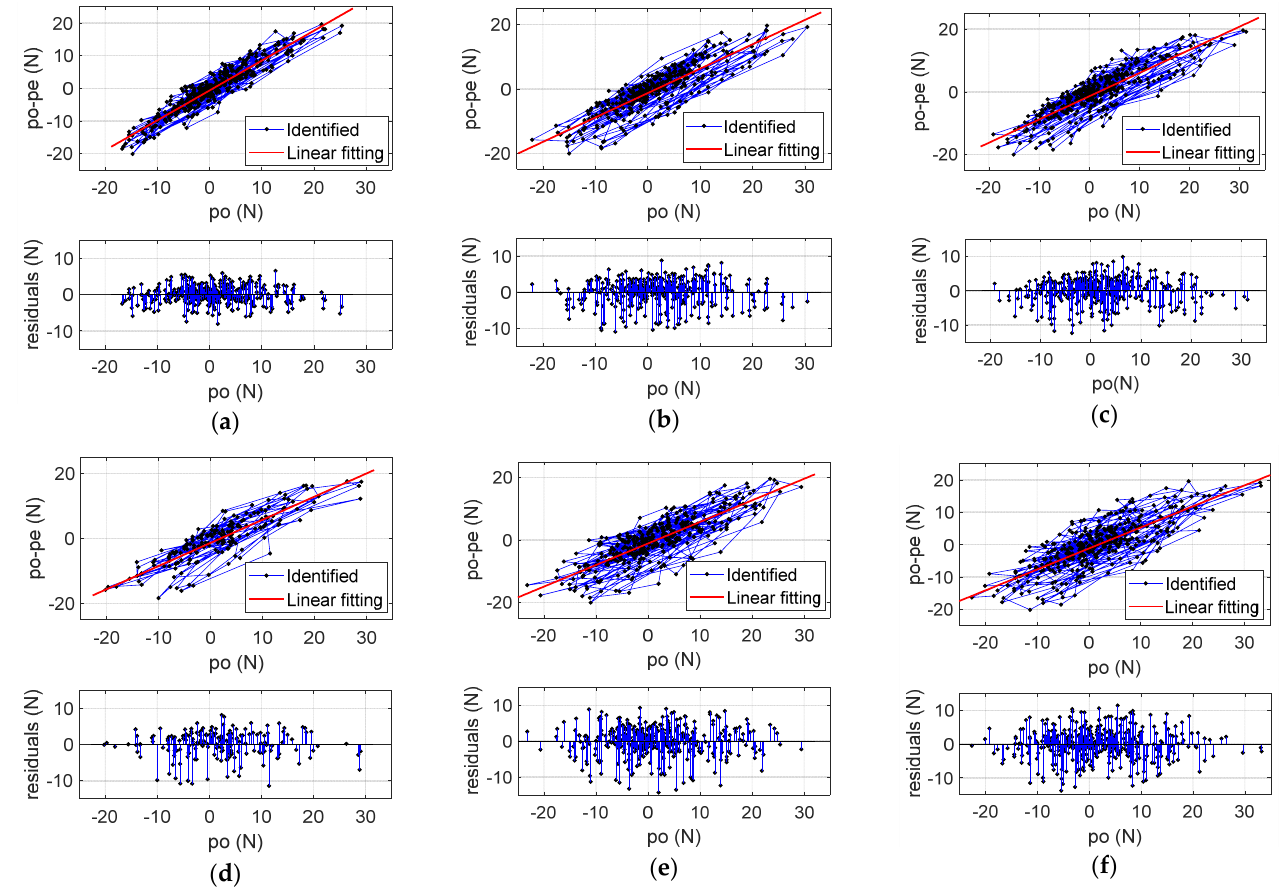
Figure 8. Identified and fitted results of 𝜻 𝟏 . ( a ) Case 1; ( b ) Case 2; ( c ) Case 3; ( d ) Case 4; ( e ) Case 5; ( f ) Case 6.